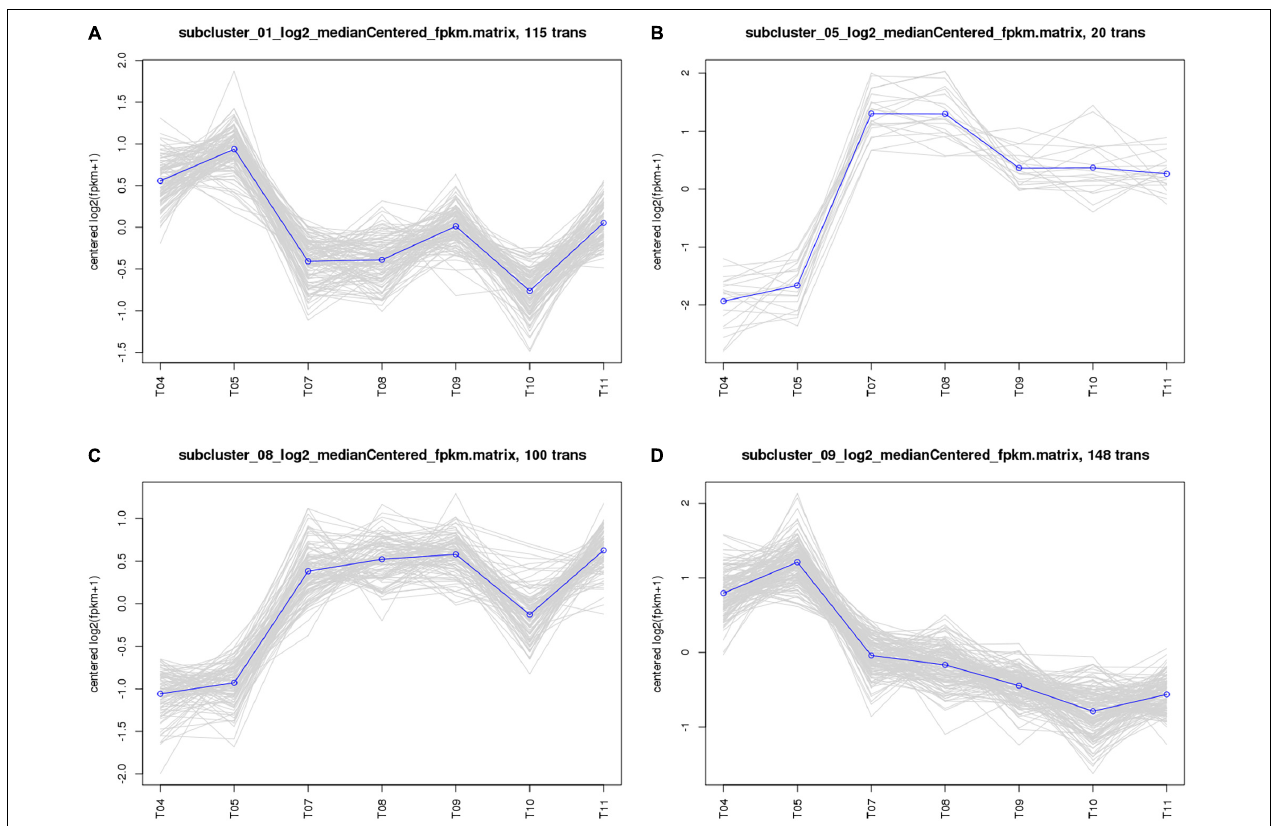
FIGURE 3 | Analysis of co-expressed patterns of HL treatments. (A) Subcluster_01. (B) Subcluster_05. (C) Subcluster_08. (D) Subcluster_09. The abscissa represents different sample, the vertical axis represents centered log2 (fpkm + 1). Four clusters were identified based on expression levels in seven different samples. T04–T05 are the two biological duplicates of the original strain PA1.2620; T07–T08 are the two biological duplicates of the PA-60 strain; T09–T11 are the three biological duplicates of PA-99 strain.